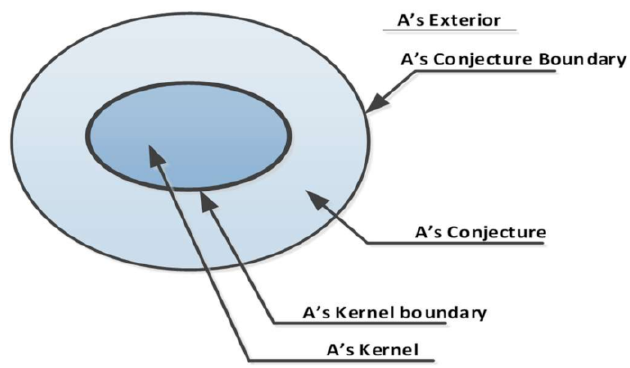
Figure 2. Topological parts of a simple fuzzy crisp region (adapted from